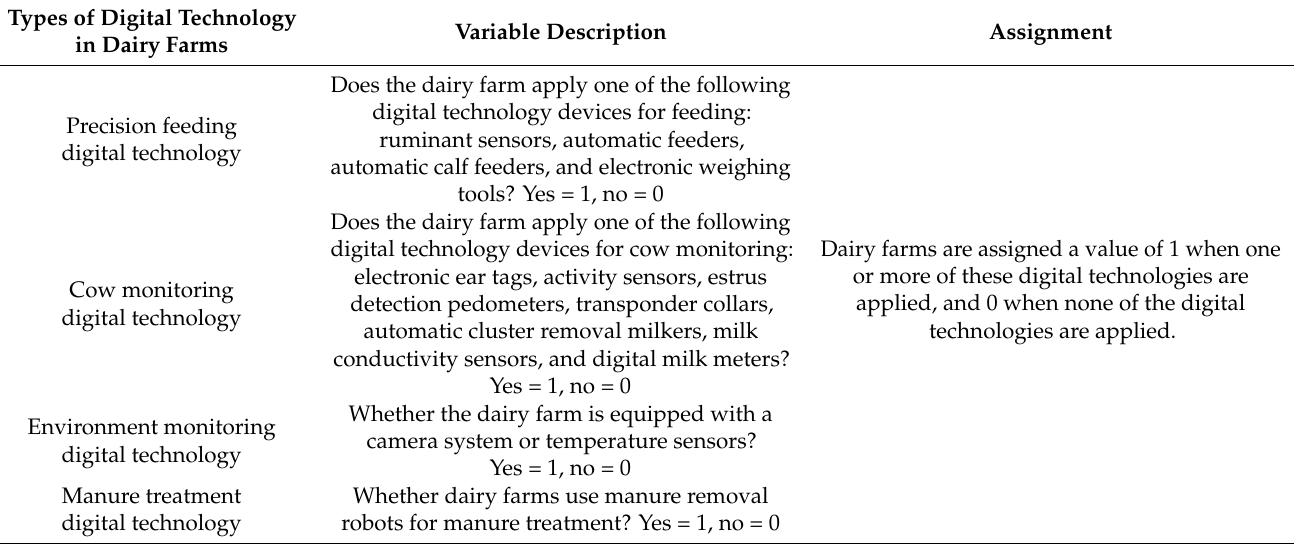
Table 2. Digital technology application evaluation index system and index assignment in dairy